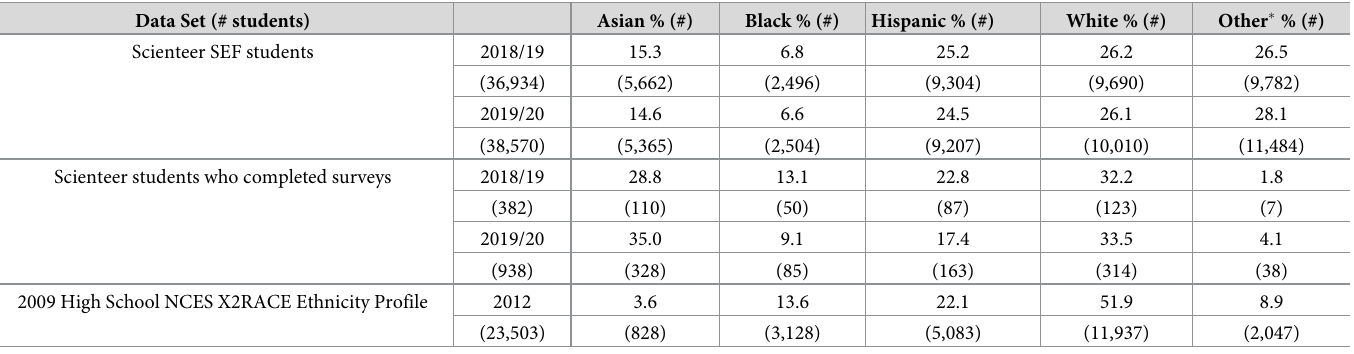
Table 1. Number and ethnic distribution of students who signed up for SEF using Scienteer, Scienteer students who participated in the SEF survey, and overall U.S high school students. Data Set (#